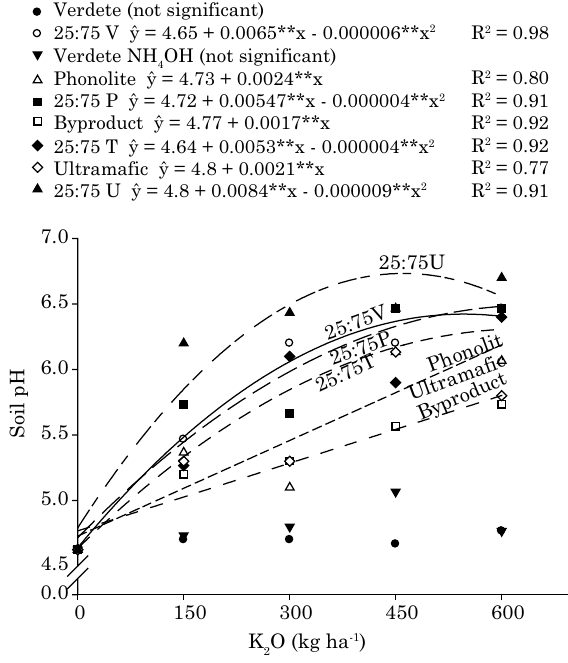
Figure 1. Effect of the different treatments and K rates on soil pH, after a 45-day incubation. *significant at 5 % by the Scott Knott test. Non-significant for verdete and verdete mixed with NH 4